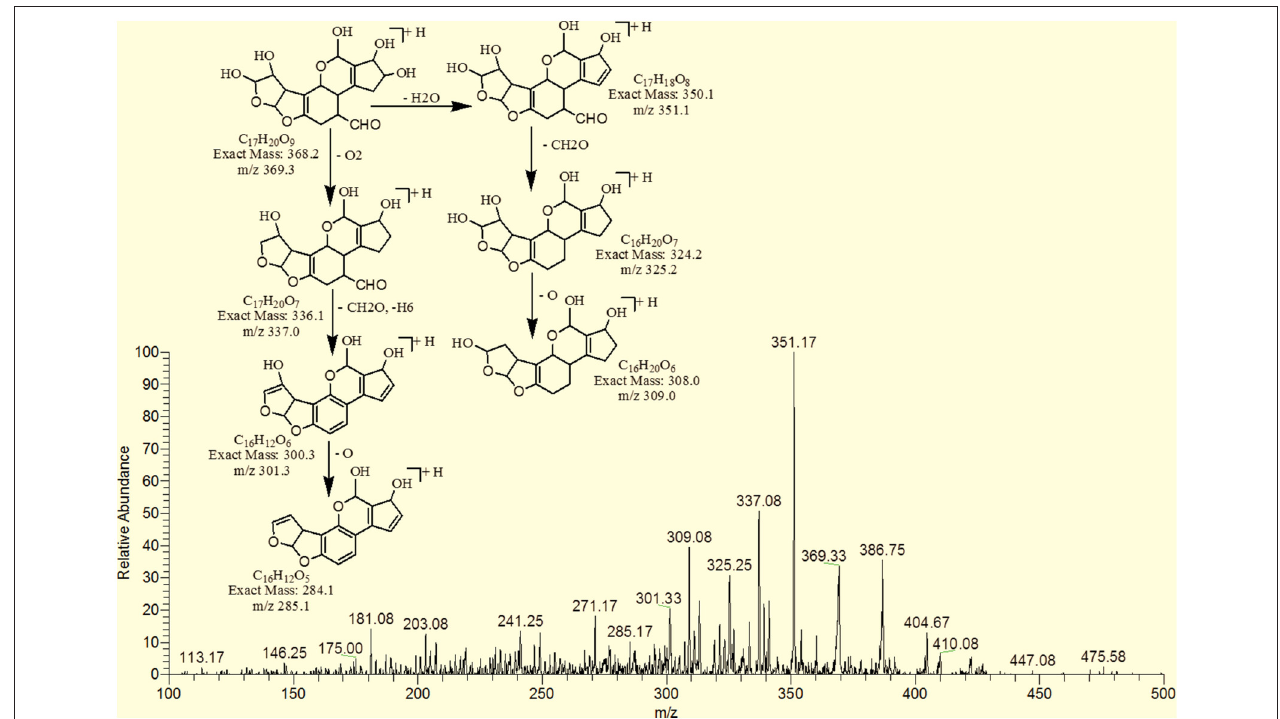
FIGURE 7 | MS/MS spectra and fragmentation pathway of degradation product with